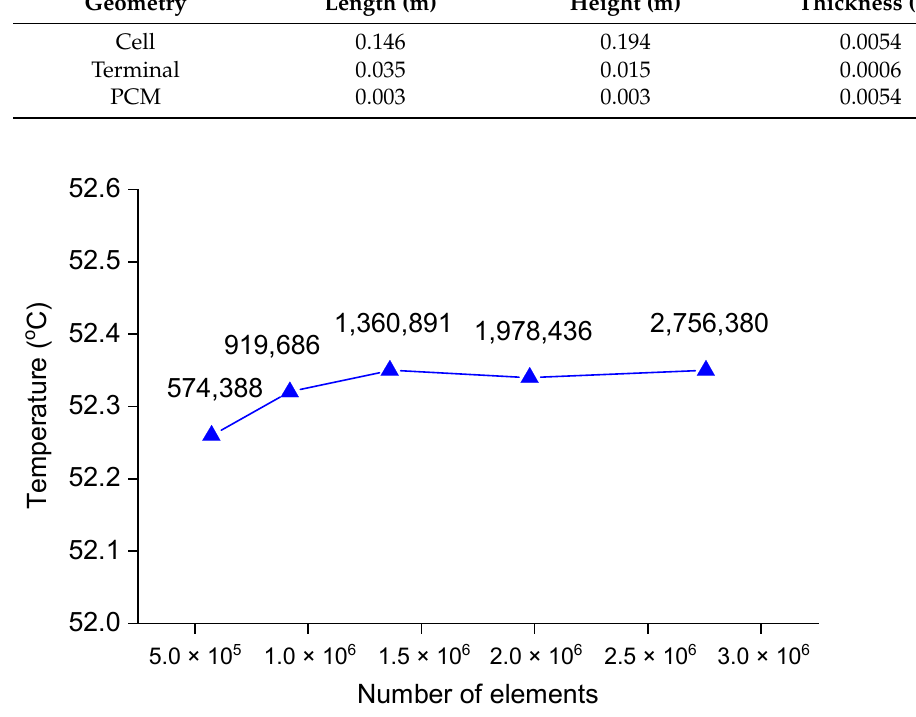
Figure 7. Grid independence test with different numbers of elements.